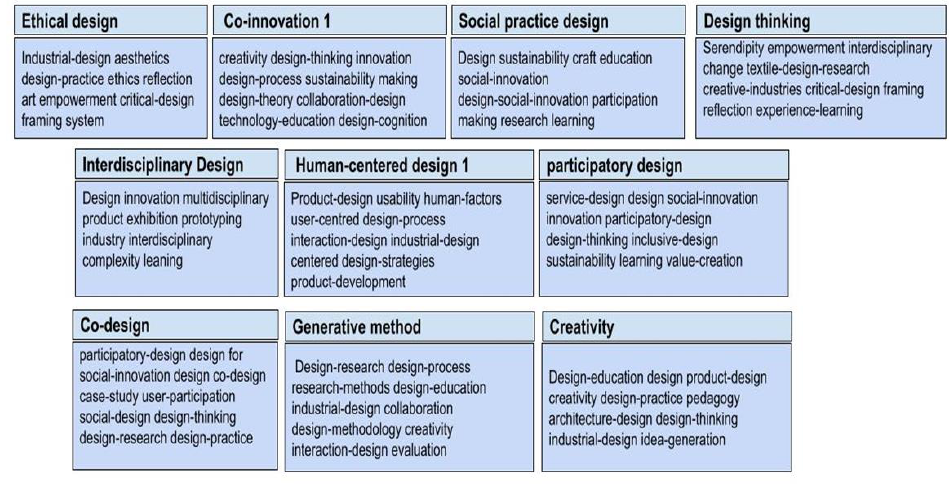
Figure 10. The ten clusters for the time-span 2016 – 2019.